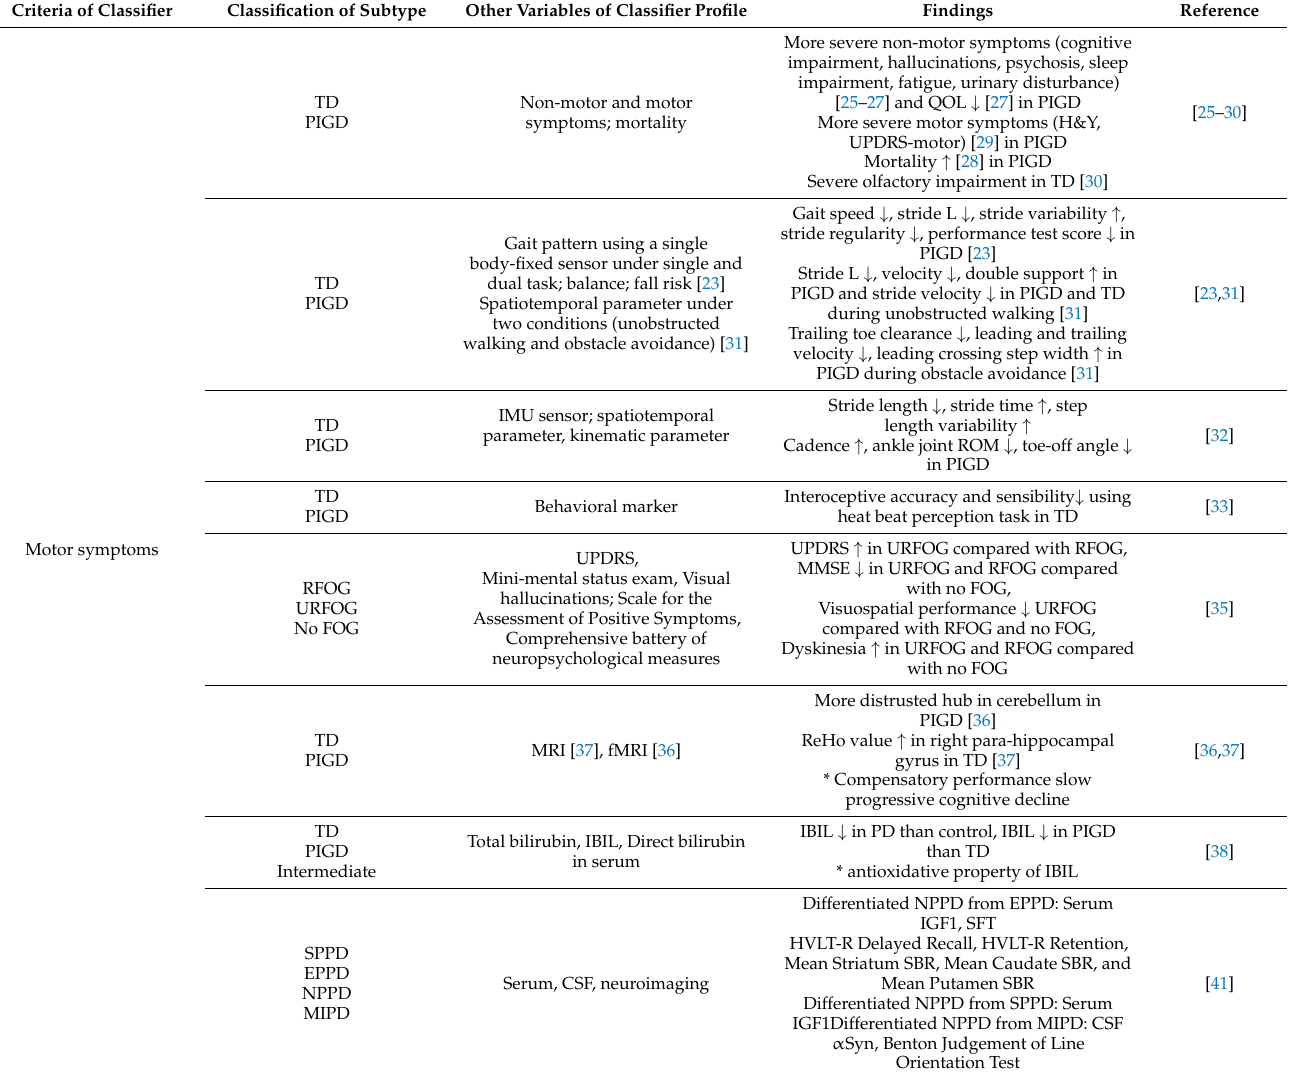
Table 1. The classification of subtypes according to the clinical features in patients with Parkinson’s disease